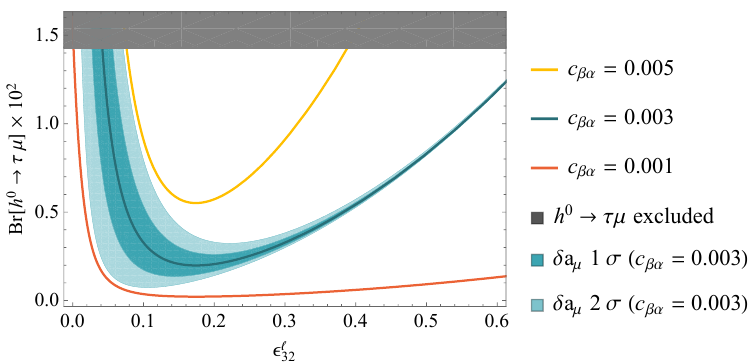
Figure 9 . Prediction for the decay of the SM-like Higgs boson h ! (cid:28)(cid:22) as a function of " ‘ under 32 the assumption that " ‘ is chosen in such a way that the anomalous magnetic moment of the muon 23 is explained. We used M = 400GeV, M H = 250GeV and M A = 300GeV. For c (cid:12)(cid:11) = 0 : 003 the H + 0 0 whole 2 (cid:27) region to explain a (cid:22) is shown while for c (cid:12)(cid:11) = 0 : 001 and c (cid:12)(cid:11) = 0 : 005 only the